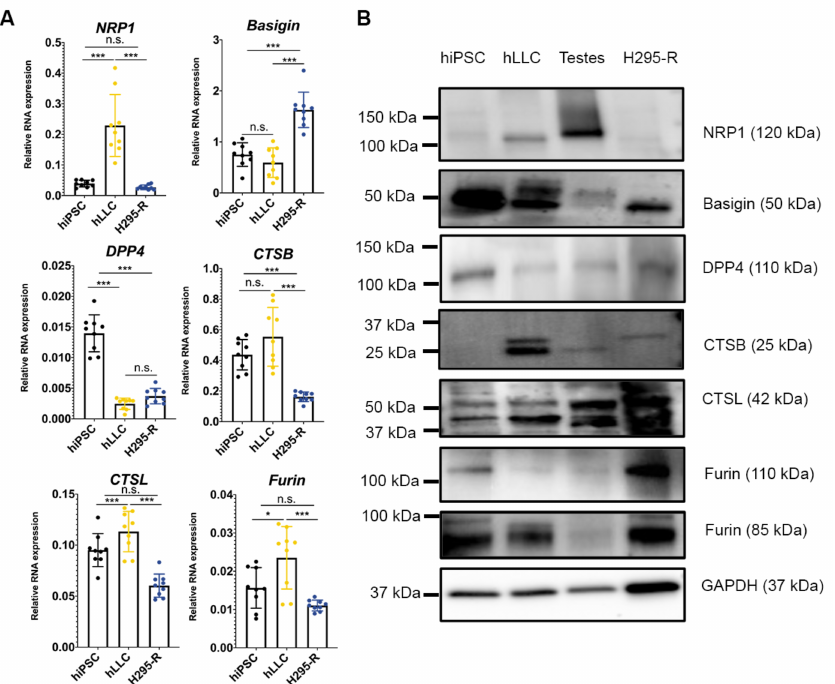
Figure 7. Potential pathways of SARS-CoV-2 entry in hLLCs. ( A ) The qPCR analyses show that SARS-CoV-2 receptors, including neuropilin-1 (NRP1), basigin, and dipeptidyl peptidase-4 (DPP4), and potential SARS-CoV-2 proteases, including cathepsin B (CTSB), cathepsin L (CTSL), and furin, which are responsible for spike cleavage, are highly expressed in hLLCs and H295-R cells. The hiPSCs used for hLLC derivation were used as a control. Data are presented as means ± SDs, n ≥ 3. Not significant = n.s. at p > 0.05; * p < 0.05; *** p < 0.001. ( B ) NRP1, basigin, DPP4, CTSB/L, and furin are all expressed in hLLCs and human testes, whereas NRP1 is not present in H295-R cells and hiPSCs. Moreover, CTSB is not expressed in hiPSCs, suggesting that entry pathways of SARS-CoV-2 do not fully overlap between hLLCs, H295-R cells, and